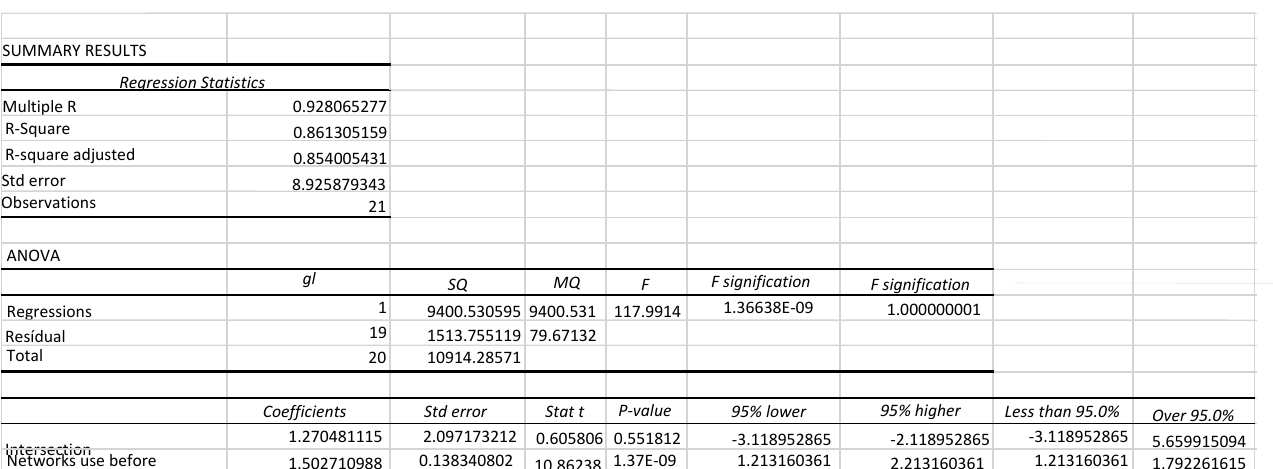
Figure 8. The linear progression for social network use. The number of people who used social networks and the number of people who participated in recreational and socializing activities present high variability within these 20 elderly care institutions. The statistics show an increase in the number of residents using social networks ( p -value 0.180) and a decrease in the number of residents participating in recreational and socializing activities ( p -value 0.001). The change in the way of socialization shows that the activity is fundamental to maintaining sustainable relationships inside and outside the LTC institutions, allowing the internal elderly to be in touch with their loved